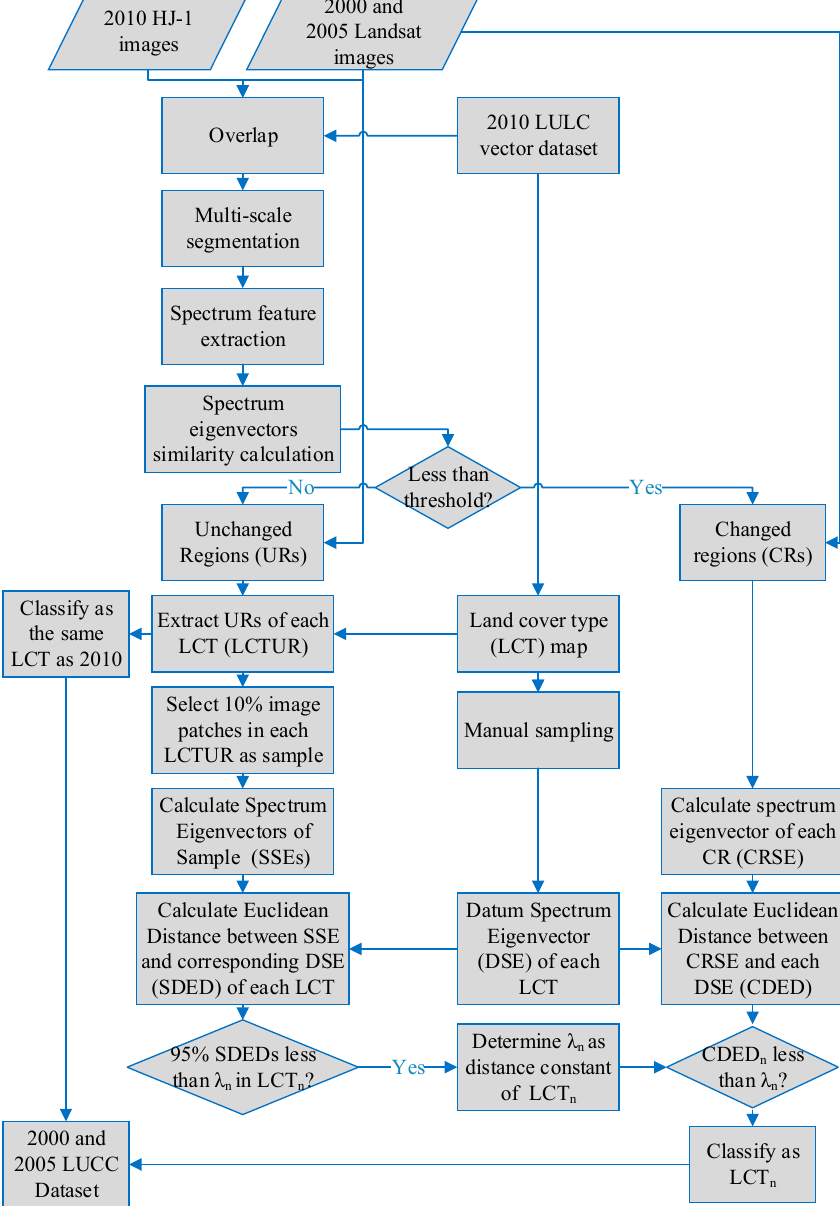
Figure 2. The workflow used to generate the 2000 and 2005 land use and land cover datasets.